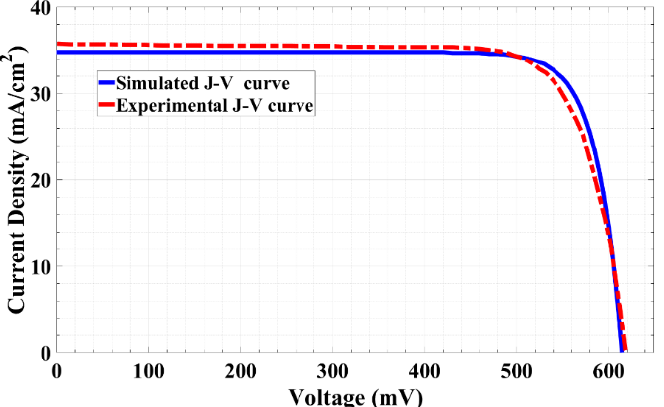
Table 1. TCAD results for the calibrated cell in comparison with experimental data.